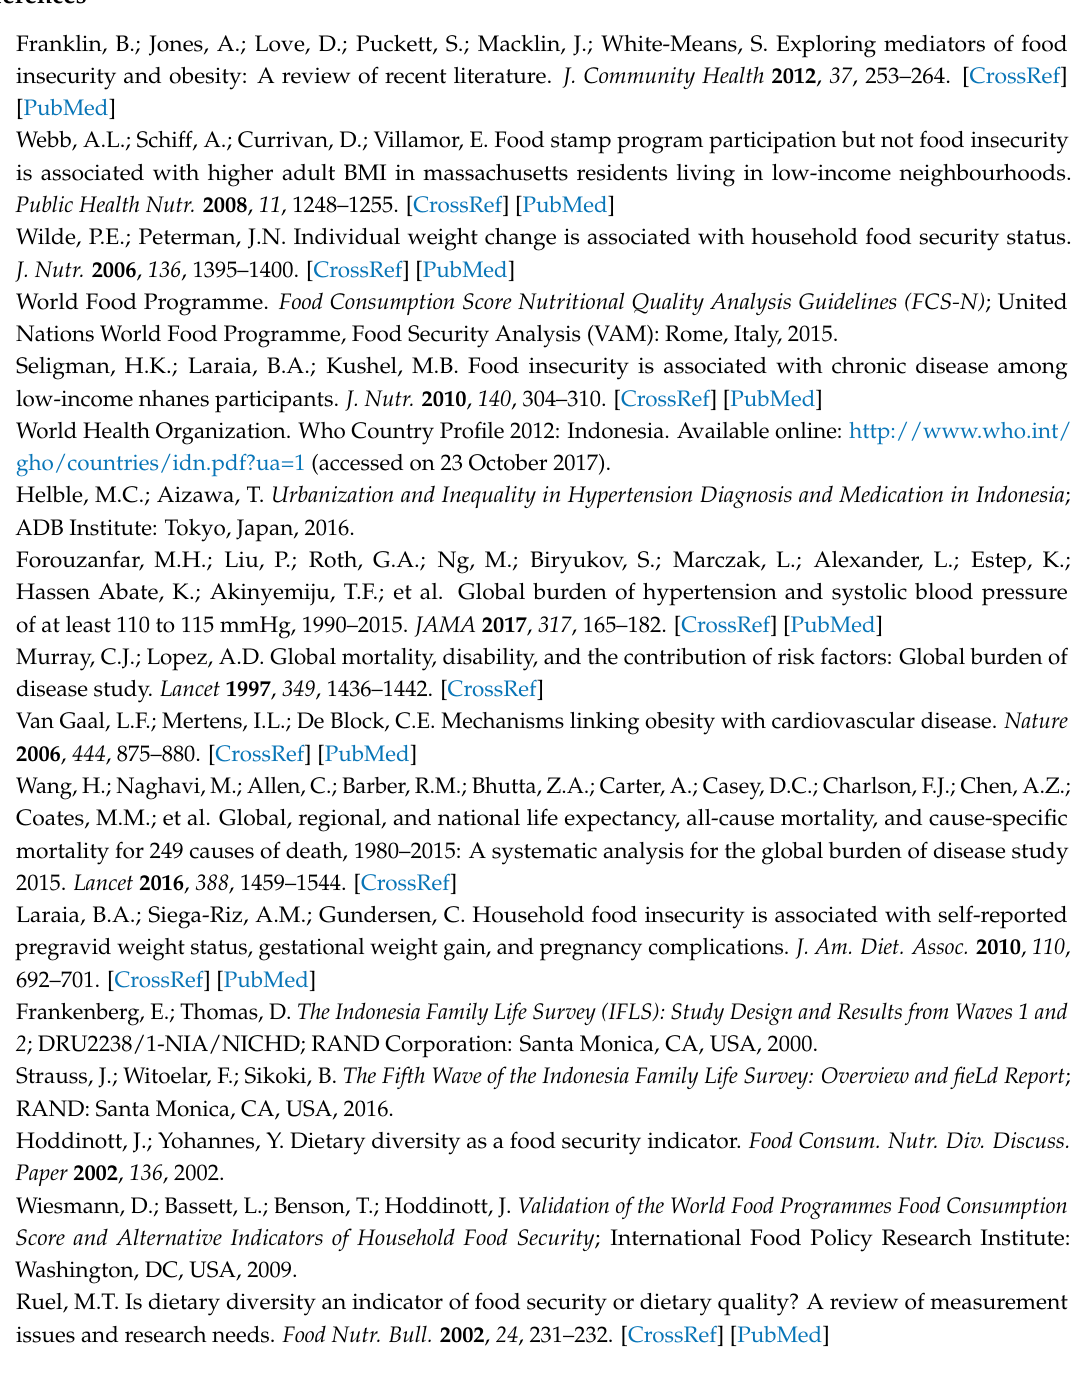
Table S1: The percentages in food consumption score changes between 2007 and